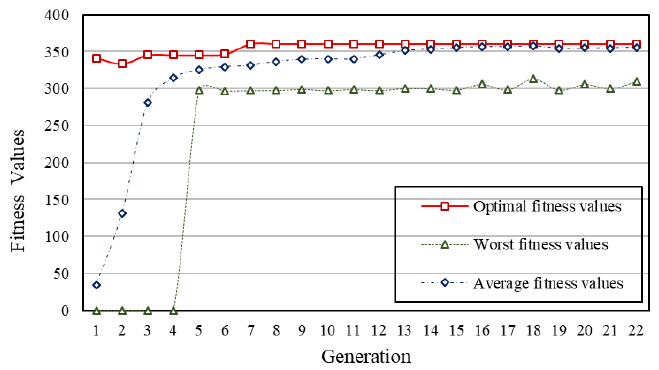
Figure 11. The Performance of this Proposed Planning Mechanism.